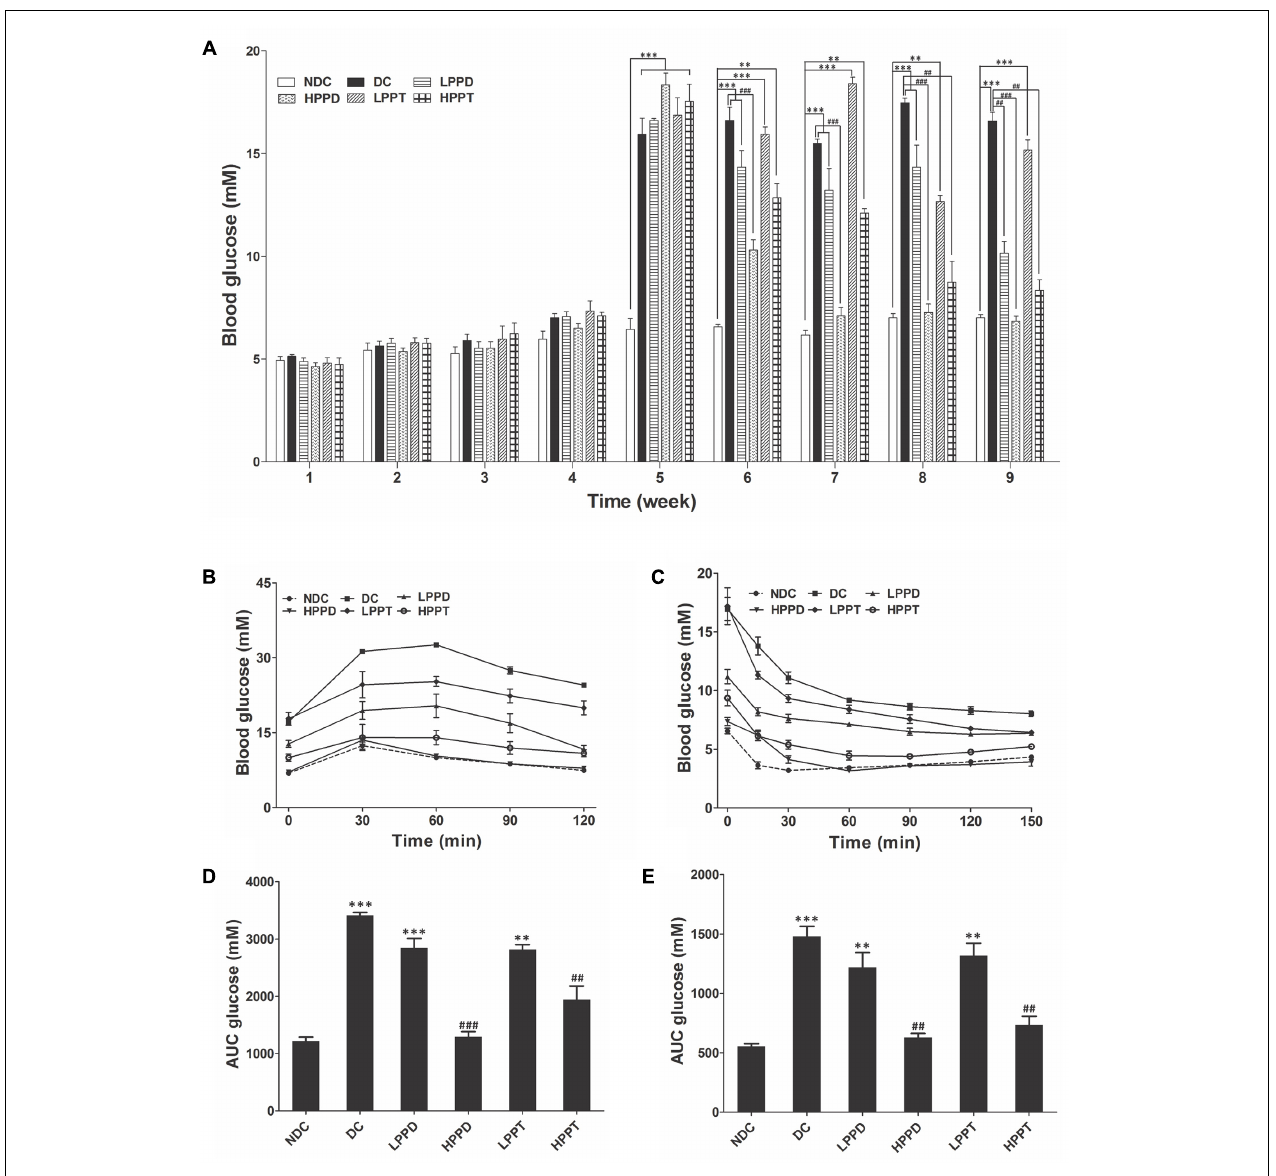
FIGURE 4 | Effects of PPD and PPT on (A) FBG, (B) GTT, (C) ITT, and (D,E) AUC glucose in high-fat diet and STZ-induced diabetic mice. ∗ p < 0.05, ∗∗ p < 0.01, ∗∗∗ p < 0.001 vs. NDC group; # p < 0.05, ## p < 0.01, ### p < 0.001 vs. DC group. Different groups were significantly different ( p <